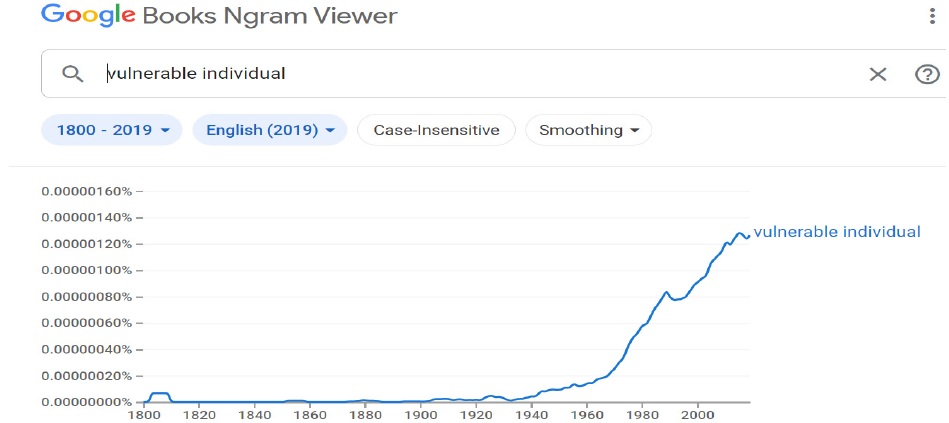
Figure 1. Google Ngram Searching Result of term ‘Vulnerable Individual’.